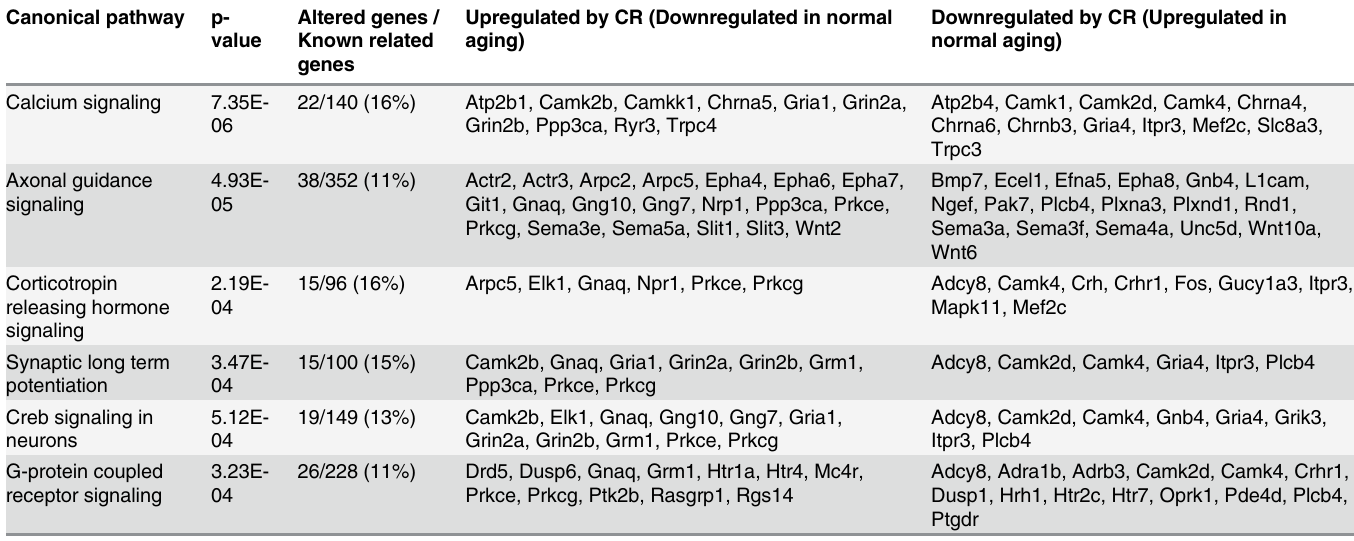
Table 1. Canonical pathways functionally associated with CR-suppressed expression signature in older-adult hippocampal CA1. (p < 0.01, q < 0.05). Canonical